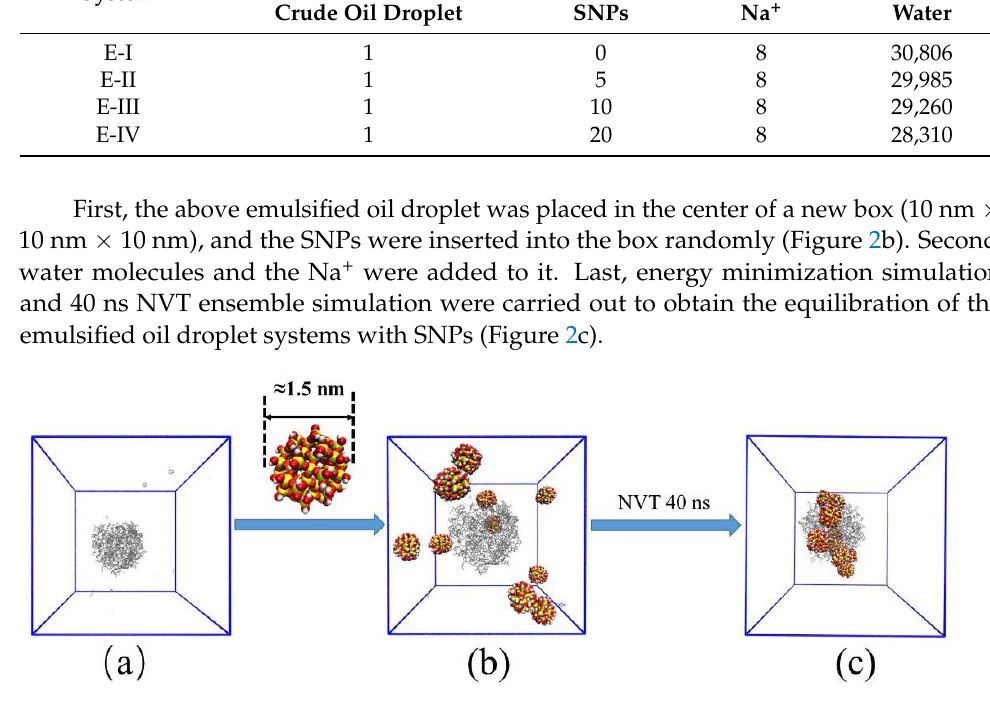
Figure 2. Schematic diagram of building emulsified oil droplet model with SNPs. For clarity, water molecules are not shown. Initial simulation box without SNPs ( a ). Initial simulation box with SNPs ( b ). Simulation box after NVT ensemble ( c ).